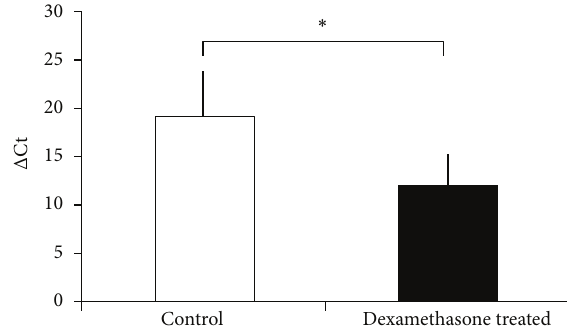
Figure 3: Expression change of secreted hsa-miR-27a after 100nM dexamethasone treatment for 8 hours in the NCI-H295R adreno- cortical cell line mediums normalized to cel-mir-39 . Δ Ct values are represented: increased Δ Ct indicates lower expression, whereas decreased Δ Ct indicates higher expression (mean ± SD). ∗ 𝑝 < 0.05 , 𝑛 = 4 . Results of 𝑡